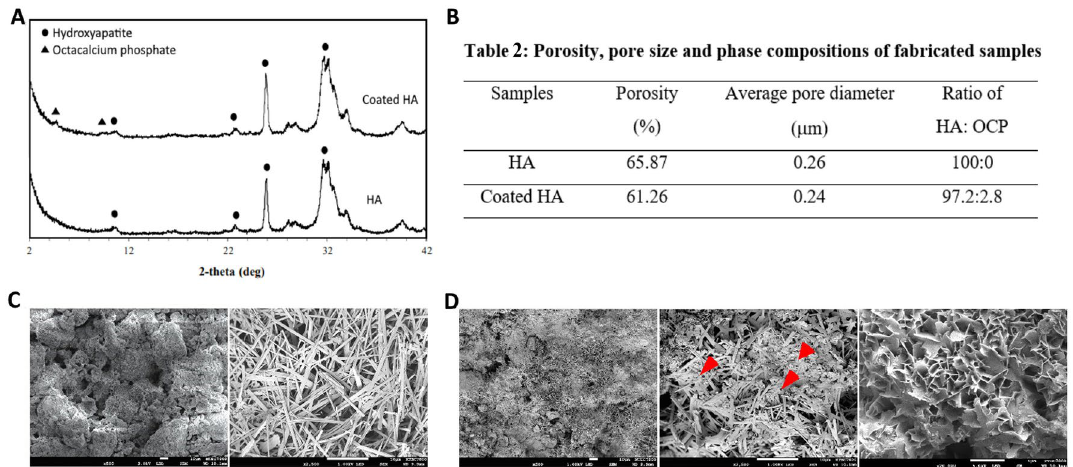
Figure 1. The characteristics of 3D-printed scaffolds. ( A ) The XRD patterns showing the broad peaks of both samples indicate low crystalline nature and a monophasic phase of hydroxyapatite in the HA sample and hydroxyapatite/octacalcium phosphate phases in the coated HA sample. ( B ) Table displaying the porosity, pore size, and phase ratio of HA: OCP of the samples. ( C ) Microstructure of 3D-printed HA (HA) showing a porous nature (left, × 500) which was formed by the entanglement of the needle-like crystals of HA (right, × 2,500). ( D ) Microstructure of coated 3D-printed HA (coated HA) showing a porous structure (left, × 500) comprising a mixture of the needle-like crystals of HA and the OCP crystals as indicated by red arrows (middle, × 2,500), which were leaf-like crystals (right, ×